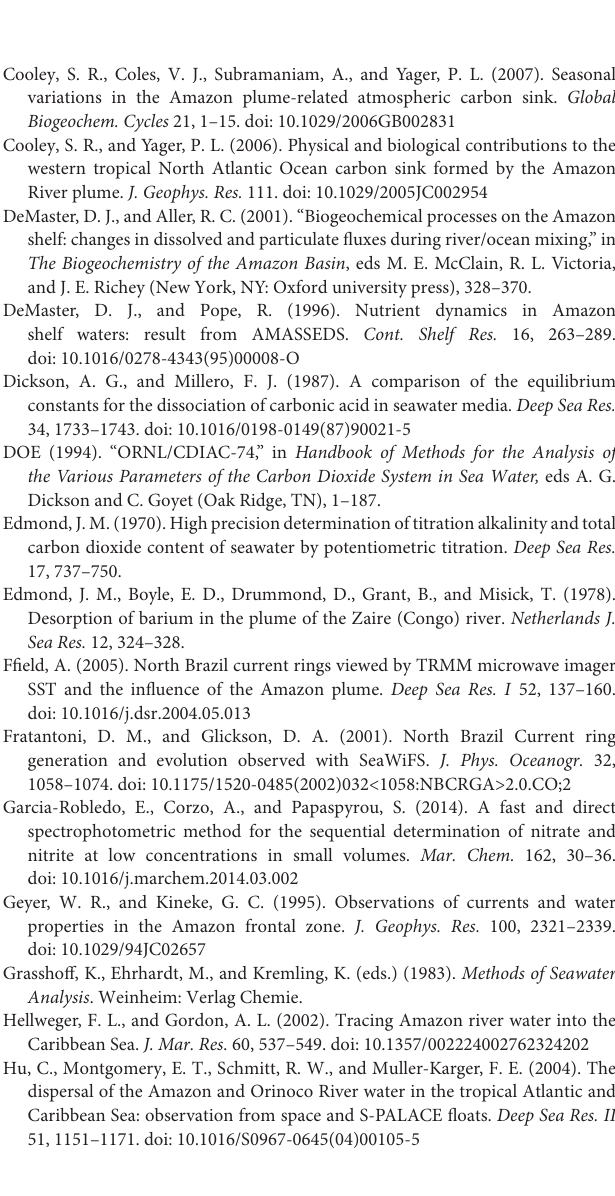
Supplementary Figure 1 | Spectra of excitation and emission for the 4 components of the